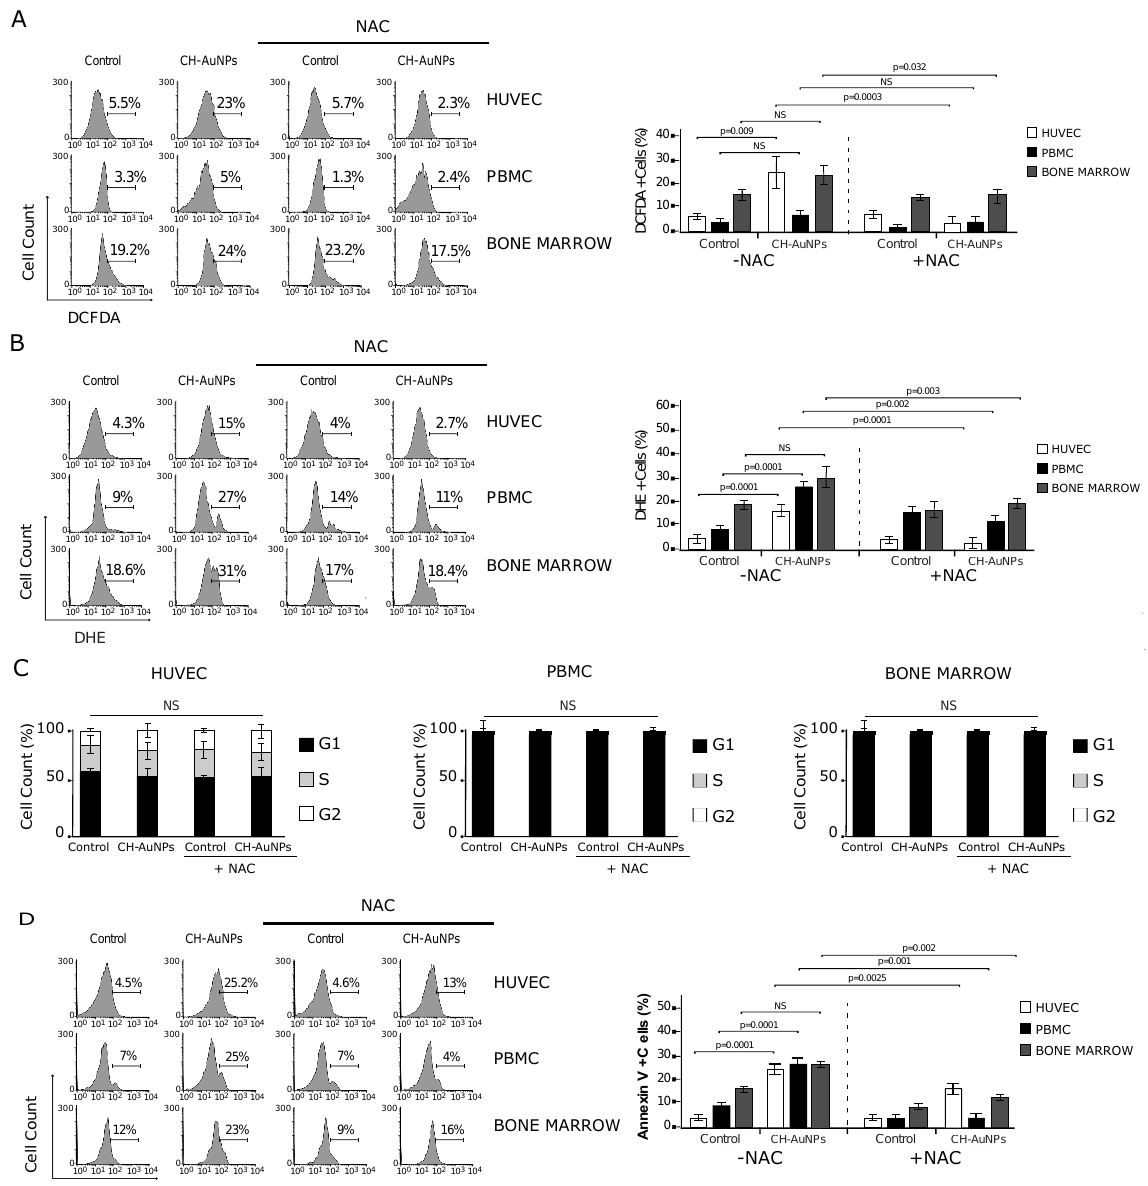
Figure 4. ROS production analysis and implication in cell cycle and cell death in HUVECs, PBMCs and BMCs upon CH-AuNP treatment. ( A ) Analysis (left) and quantification (right) of ROS (H 2 O 2 ) production by flow cytometry using DCFDA staining and NAC as a ROS inhibitor in HUVECs, PBMCs, and BMCs treated with CH-AuNPs for 24 h. ( B ) Analysis (left) and quantification (right) of ROS (O 2 − ) production using DHE staining and NAC as a ROS inhibitor by flow cytometry in HUVECs, PBMCs, and BMCs upon CH-AuNP treatment for 24 h. ( C ) Quantification of cell-cycle analysis in HUVECs, PBMCs, and BMCs treated with CH-AuNPs and using NAC as a ROS inhibitor for 24 h. ( D ) Analysis (left) and quantification (right) of phosphatidyl serine exposure analysis by flow cytometry using annexin V-APC (AnnexinV) staining and NAC as a ROS inhibitor in HUVECs, PBMCs, and BMCs treated with CH-AuNPs for 24 h. The results are presented as mean ± standard deviation of three different experiments. NS = not